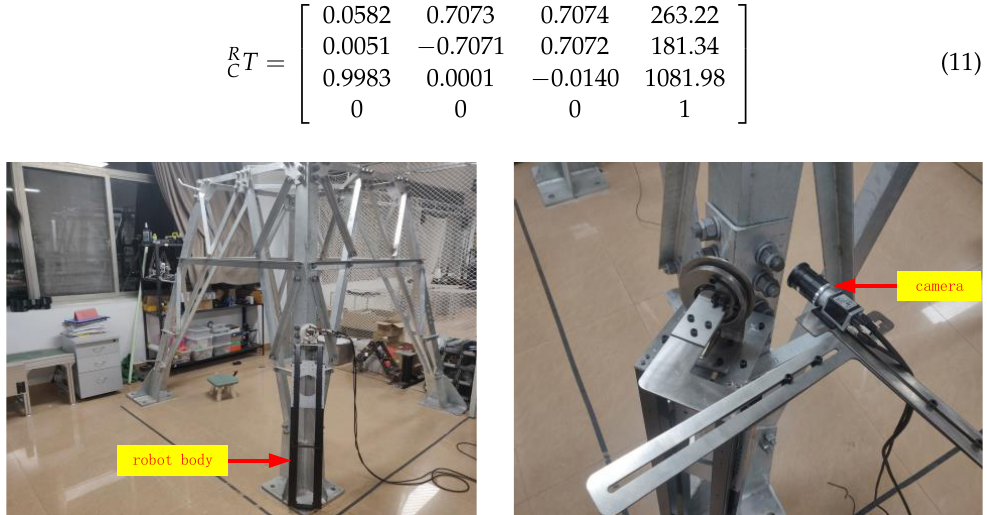
Figure 14. Positioning experiment